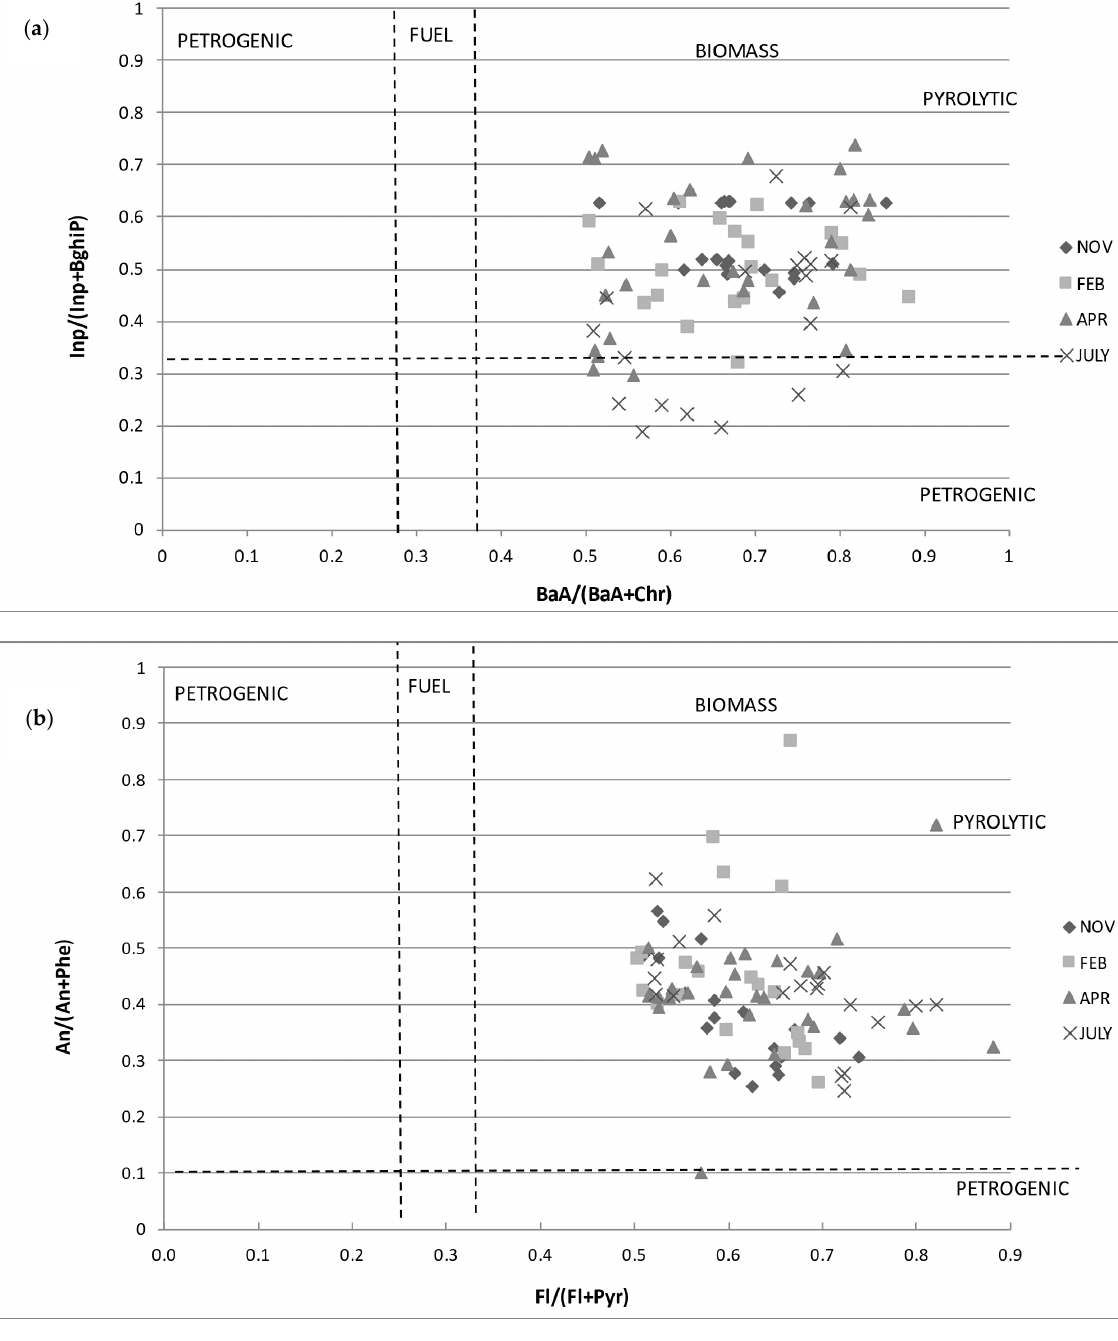
Figure 4. ( a ) Cross plots of the values of Fl/(Fl + Pyr) versus An/(An + Phe) and ( b ) BaA/(BaA + Chr) versus InP/(InP + BghiP) for all the samples data of the Volturno River and its Estuary.